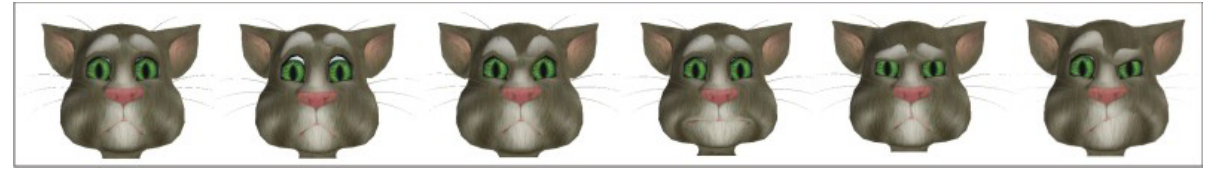
Figure 24. Expressions transferred to a cat model.